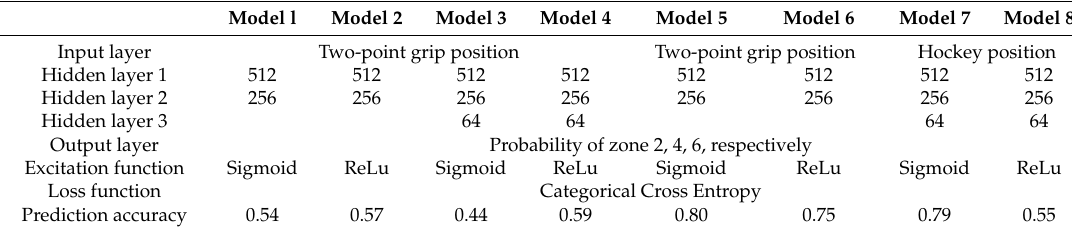
Table 5. Eight models with di ff erent parameters to train neural networks.